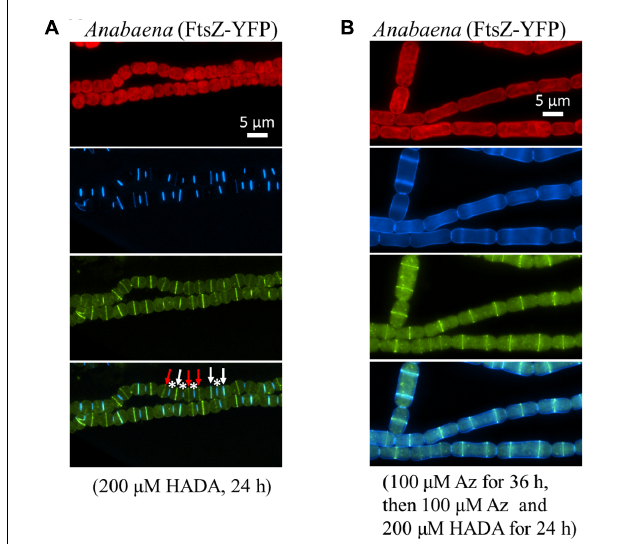
FIGURE 5 | Relationship between cell division and PG synthesis in Anabaena PCC 7120. (A) An Anabaena strain in which the cell division gene ftsZ was replaced by a ftsZ-yfp translational fusion was treated with HADA, and imaged under a fluorescence microscope. The top panel shows red photosynthetic pigment and the HADA signal in blue; the middle panel shows the Z-ring in yellow; and the bottom panel shows a superimposition of the same filaments with both HADA and FtsZ-YFP signals. Asterisks indicate cell–cell junctions labeled by HADA, white arrows indicate septa having both HADA signal and FtsZ-YFP signal, and red arrows indicate septa having FtsZ-YFP signal only. (B) The same recombinant strain as in A was treated with aztreonam (Az), an antibiotic targeting to FtsI, a PG synthase involved in cell division. Cells elongated as a consequence of cell division inhibition as previously reported (Sakr et al., 2006). The same filaments were pictured in red (photosynthetic pigments), blue (HADA), yellow (FtsZ-YFP) and superimposition of the HADA and YFP